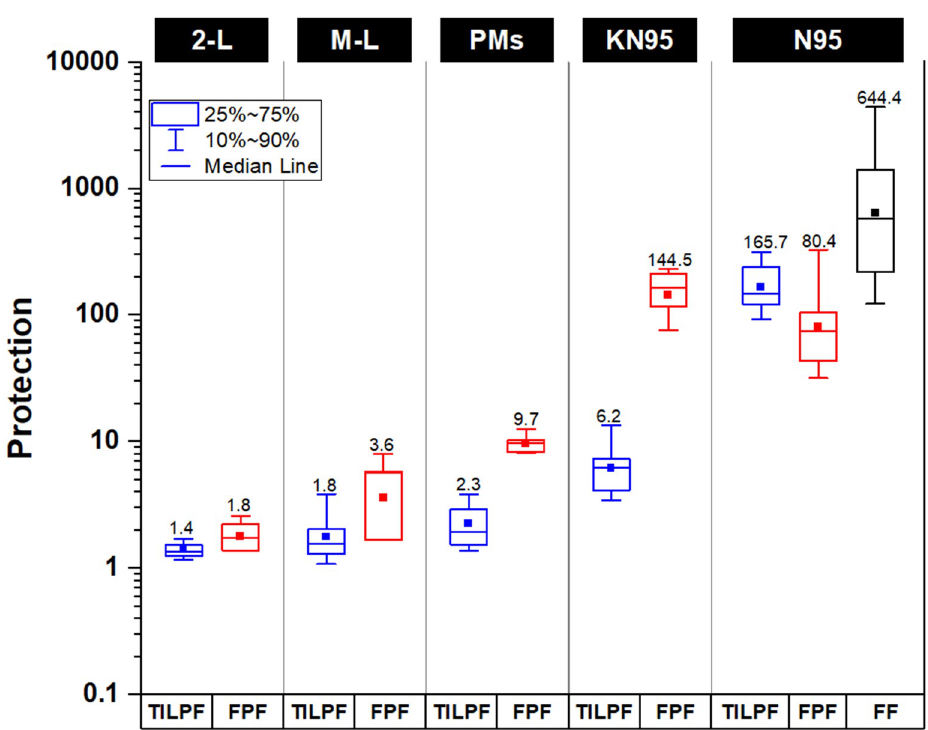
Fig 9. Protection performance results for the five mask groups; fabric 2-layer masks (2-L), multi-layer masks (M-L), disposable procedure masks (PMs), KN95 masks and N95 FFRs. TILPF—total inward leakage protection factor. FPF—fabric protection factor (overall protection of fabric material against entire particle size distribution). FF —fit factor (total inward leakage measured through face seal only (by QNFT). Sample sizes: n = 8 to 26 for TILPF; n = 6 to 20 for FPF; and; n = 30 for FF. The geometric mean is shown by the square marker.